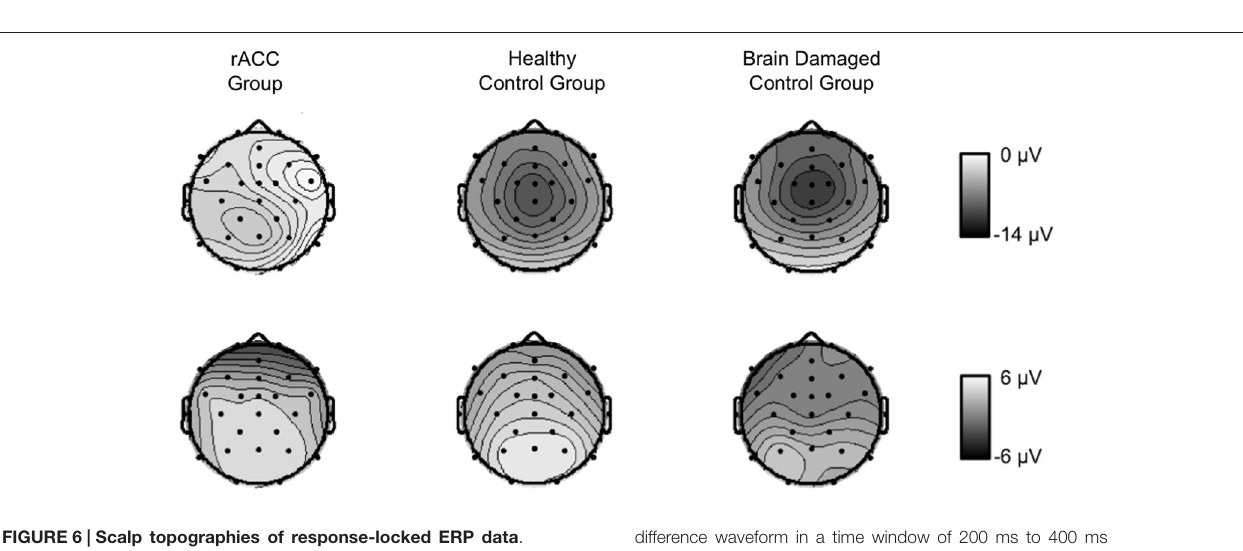
FIGURE 6 | Scalp topographies of response-locked ERP data . Grand average scalp topographies of the difference between error and correct waveforms in the Ne/ERN time window ( − 10 to 90 ms relative to the response) and in the Pe time window (100 ms centered around the most positive peak of the error—correct